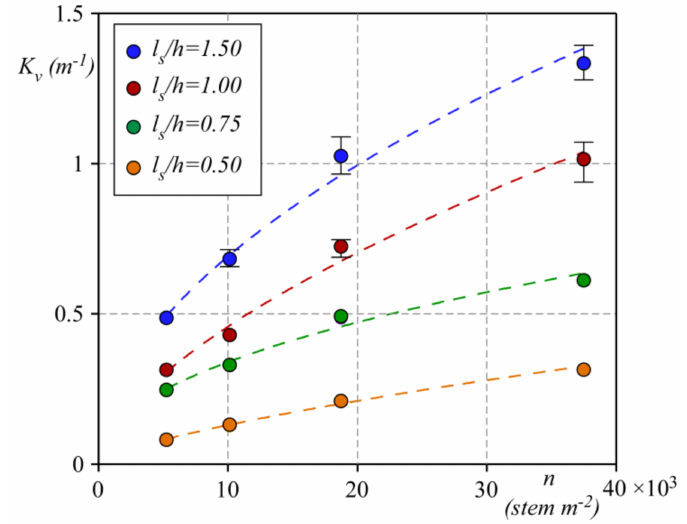
Figure 6. Coefficient of dissipation, K v , as a function of stem density, n . Average K v are computed for l s / h = 1.5 (blue circles), l s / h = 1.0 (red circles), l s / h = 0.75 (green circles), and l s / h = 0.5 (orange circles). Bars show the range of variability of K v in the present